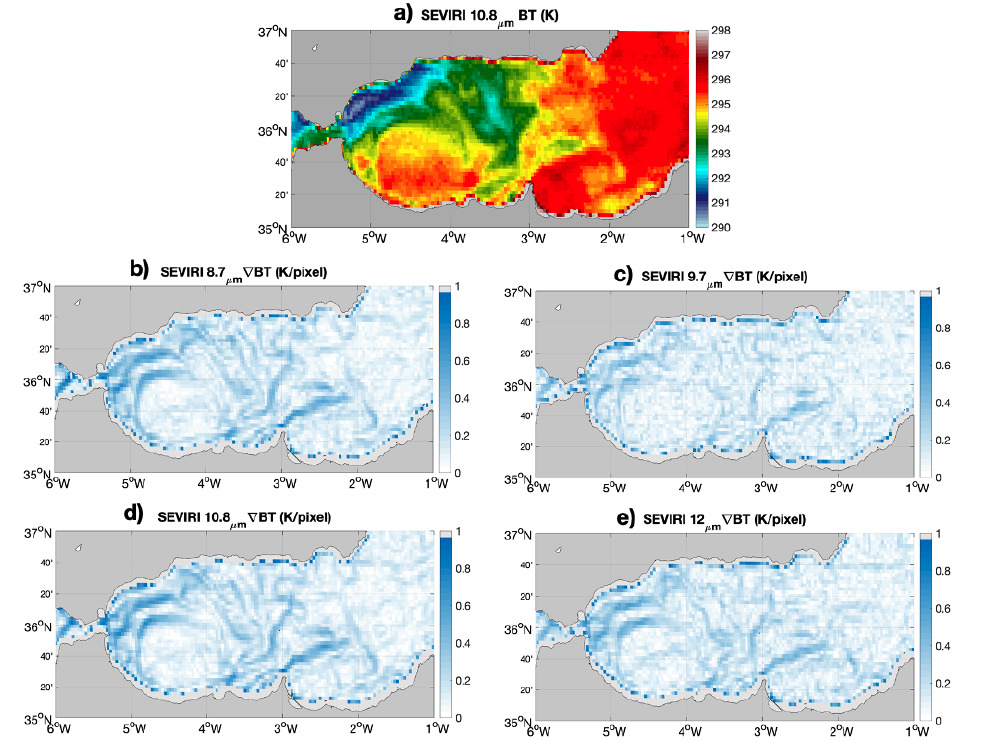
Figure 6. ( a ) TOA radiances for SEVIRI channel 9. ( b – e ) Sobel spatial gradients of the TOA radiances for channels 7 to 11. The fields refer to 5 August 2021 at 09:00